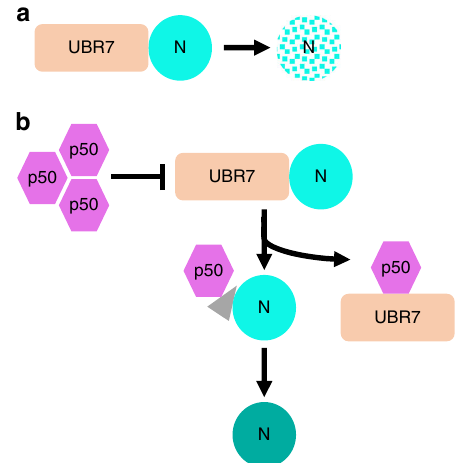
Fig. 7 A model for the functional role of UBR7 in N -mediated resistance to TMV. a In uninfected naive condition, UBR7 interacts with the TIR domain of N resulting in the relatively low expression of N. b During TMV infection, the p50 effector disrupts the interaction between UBR7 and N by interacting with UBR7, thereby releasing the N from the N-UBR7 complex and leading to increased stability of N and activation of interaction partners of a target protein. Using the TurboID-based PL, a number of new regulators involved in the N NLR-mediated immune response were identi fi ed. In particular, we found that UBR7 interacts with N and functions as a negative regulator of N - mediated defense. Our results highlight the robustness of the TurboID-based PL in probing the interactome of NLR immune receptors and also enhance our understanding of the sophisti- cated regulatory network underpinning plant innate immunity.